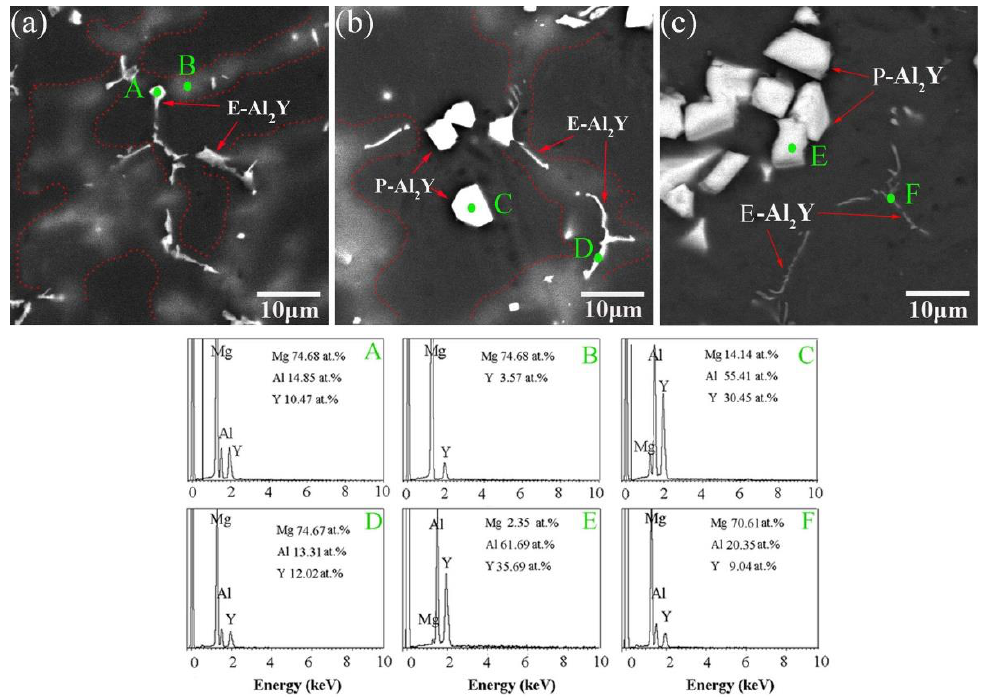
Figure 3. BSE-SEM image and EDS analysis of point A, B, C, D, E and F in SEM image of the as-cast: ( a ) YA605 alloy; ( b ) YA61 alloy; ( c ) YA65 alloy.